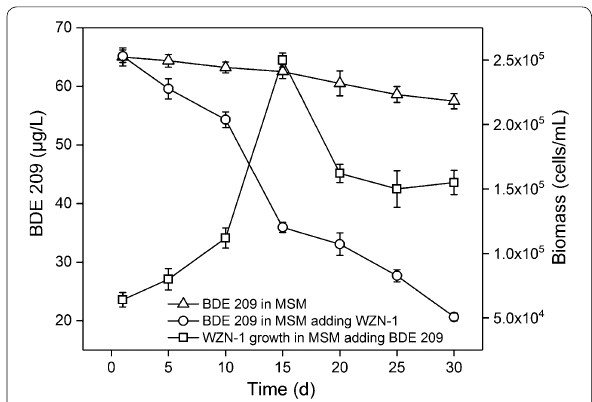
Fig. 1 Biodegradation of BDE209 by strain WZN-1 under the optimized condition. The error bars represent standard deviation of triplicate measurements